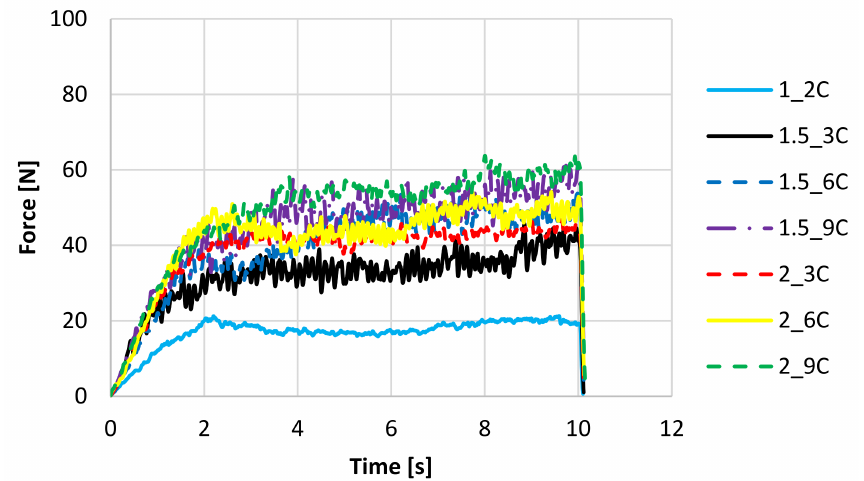
Figure 5. The cutting curves of freeze-dried fruit bars with chokeberry pomace. Denotations in Table 1 include Index (C) next to the sample symbol—bars with the chokeberry